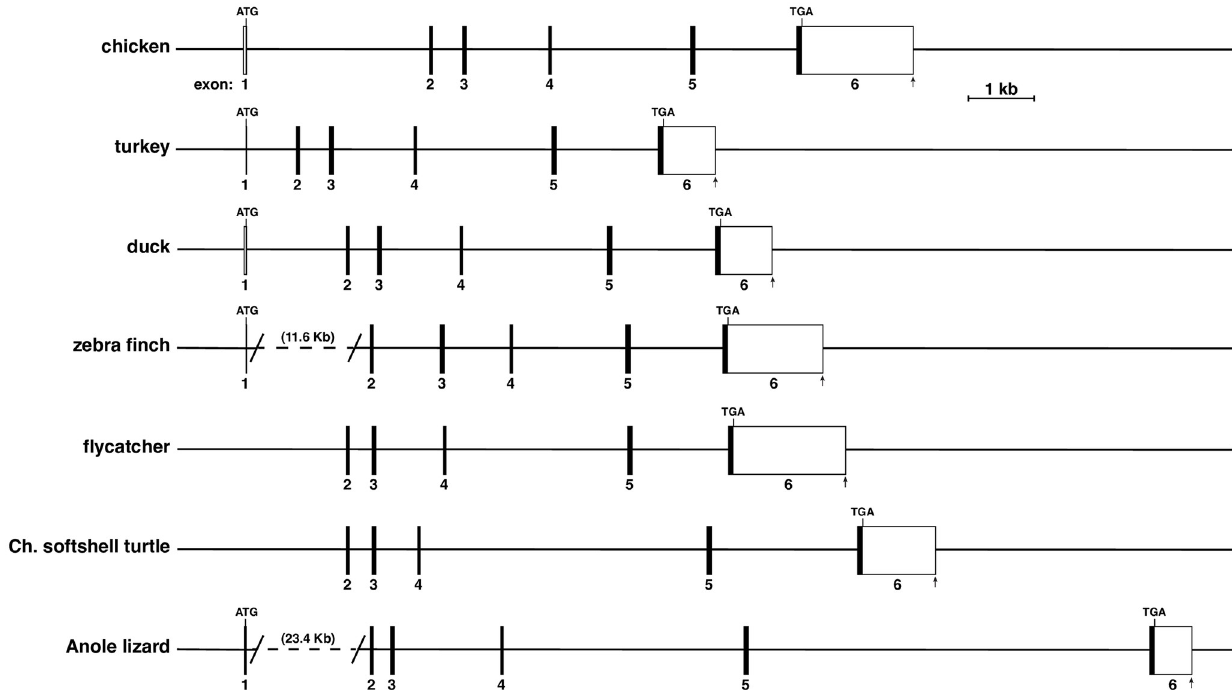
Fig 2. The Zmat2 gene in terrestrial vertebrates. Diagrams of chicken, turkey, duck, zebra finch, flycatcher, Chinese (Ch.) softshell turtle, and Anole lizard Zmat2 genes. Exons are indicated as boxes, with coding regions in black and non-coding segments in white for each gene. The locations of ATG and TGA codons are indicated, as is the putative 3’ end of exon 6 for each gene (vertical arrow). A scale bar is shown. See Tables 2 and 3 for more details.